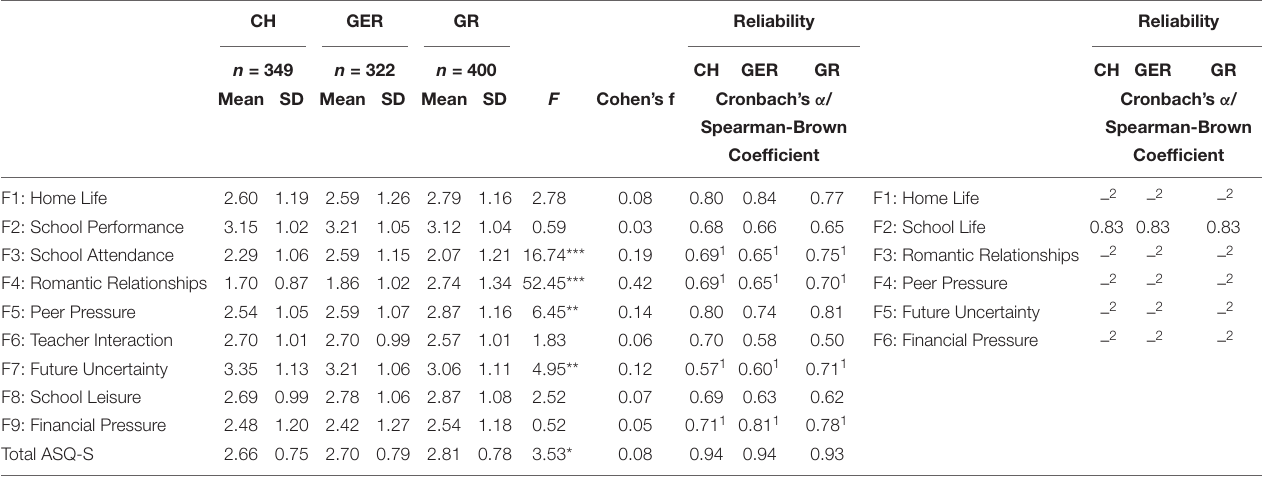
TABLE 1 | Table of means, standard deviations, and test score reliability of ASQ-S (9-factor